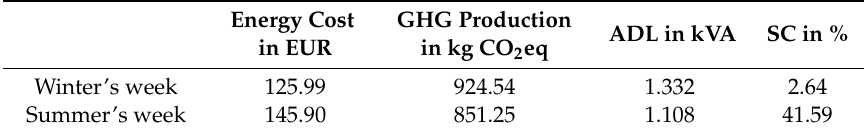
Figure 5. Comparison of the apparent power at the transformer for the baseline and 2050 scenario (70% EVs, 33% PV penetration) for a week in the winter and the heavy load case. Table 2. Comparsion of indicators for the uncoordinated charging (UC) scenario, values over one week. GHG = greenhouse gas; SC = self-consumption